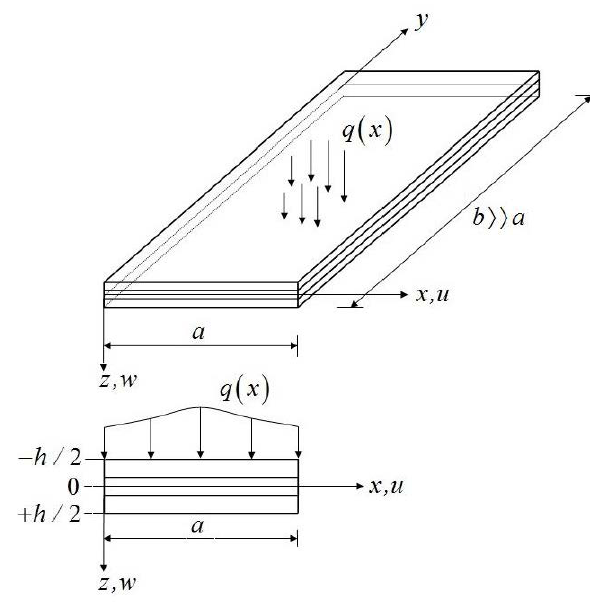
Figure 1: Plate geometry and coordinate